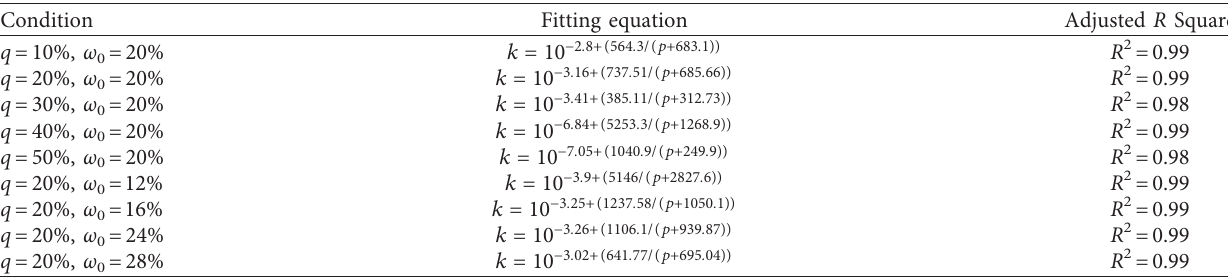
Table 5: Fitting results of k-p